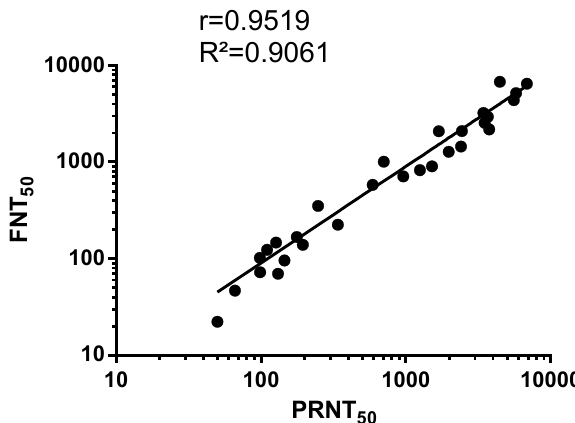
Figure 4. Scatter plots of PRNT 50 and FNT 50 values in Vero cells. PRNT: plaque-reduction neutralization test; FNT: flow-cytometry neutralization test. The PRNT 50 and FNT 50 were determined as the reciprocal of the last serum dilution that resulted in a 50% residual of infectivity of negative-control serum samples.